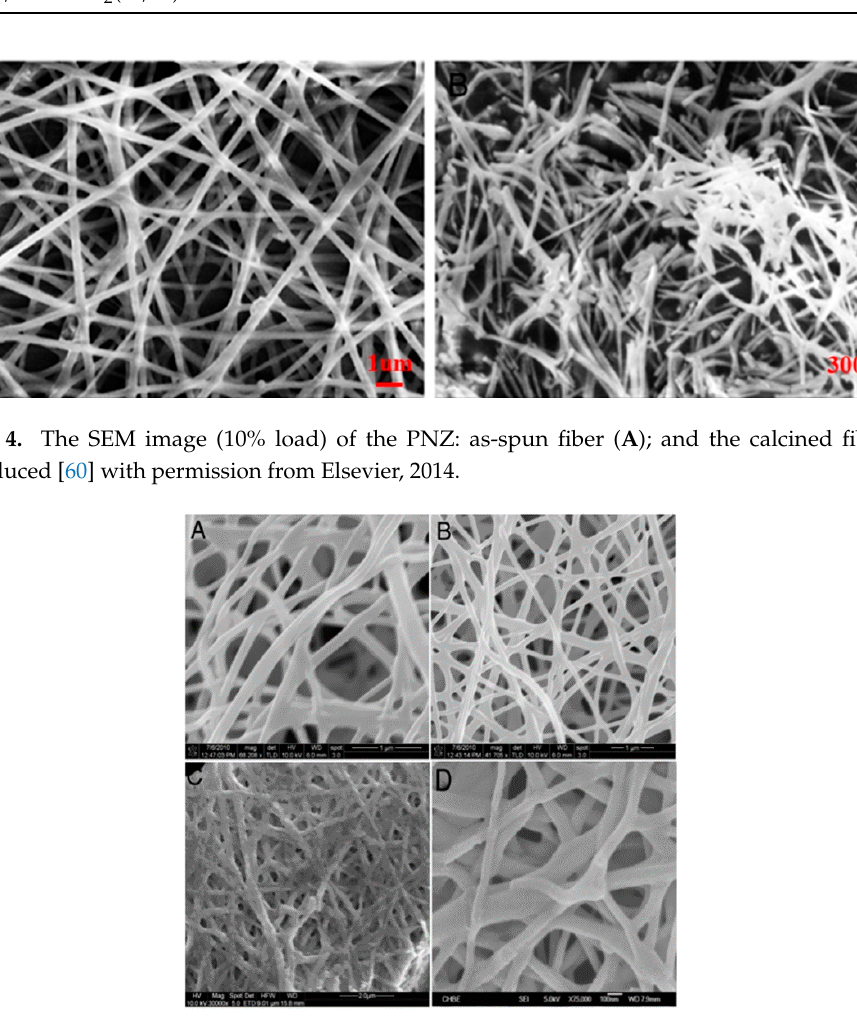
Figure 5. The SEM images of PNZ: as-spun fibers (50% loading) ( A , B ); and calcined fibers ( C , D ). Reproduced [60] with permission from Elsevier, 2014.